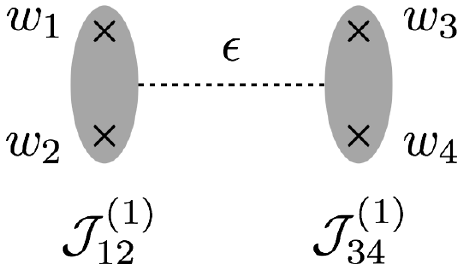
Figure 2 . The exchange diagram which computes the O (1 =C ) correction to the identity block. The blobs refer to the bilocal operators, and the vertex factors J (1) of the reparameterized two-point function to the (cid:15) (cid:12)eld and are given in (6.15). The (cid:15) propagator is given in